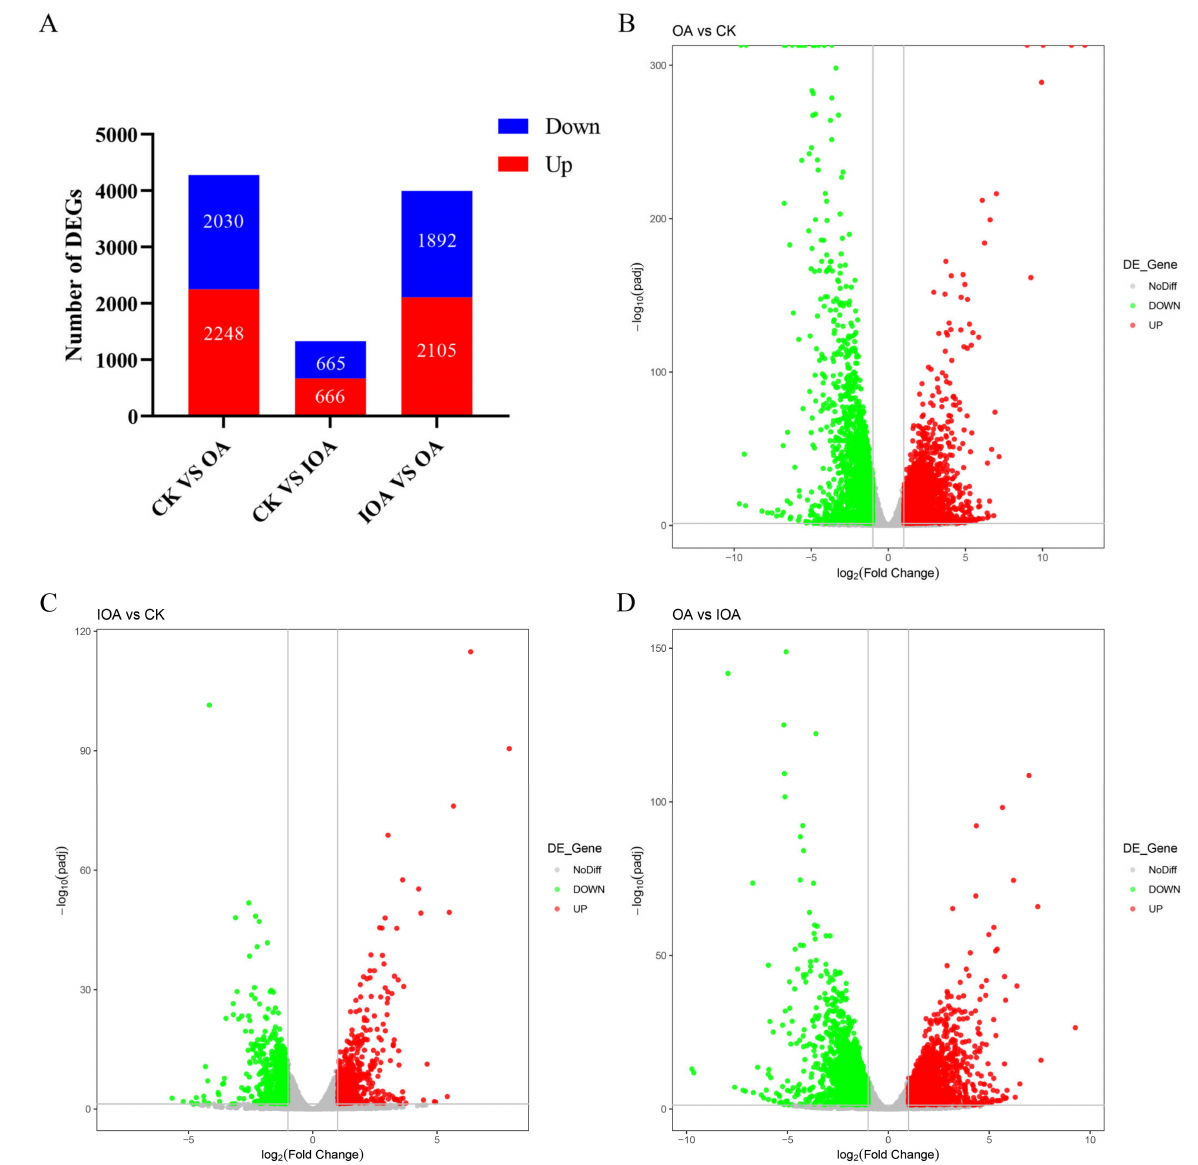
Figure 1. Overview of differential expression analysis for the CK, IOA, and OA treatments. ( A ) Num- ber of up- and down-regulated genes affected by different treatments. ( B – D ) Volcano maps of significant DEGs under different oxalic acid